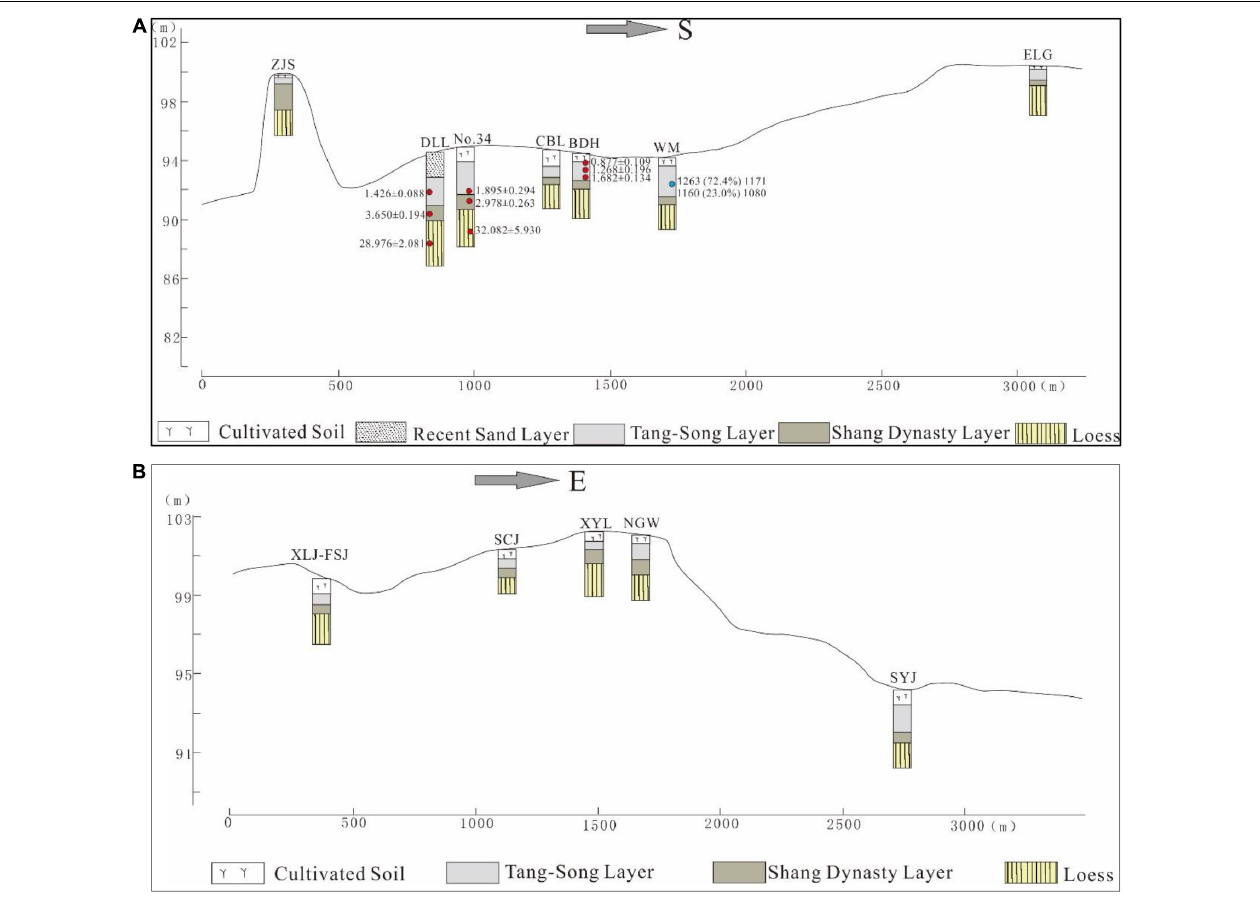
FIGURE 3 | Topographic and sedimentary features in the region of Shang City (A) . North - South; (B) . West - East. The locations of excavation sites are showed in Figure 1B . The OSL (red circle) and 14 C (blue circle) ages are marked on the graph.